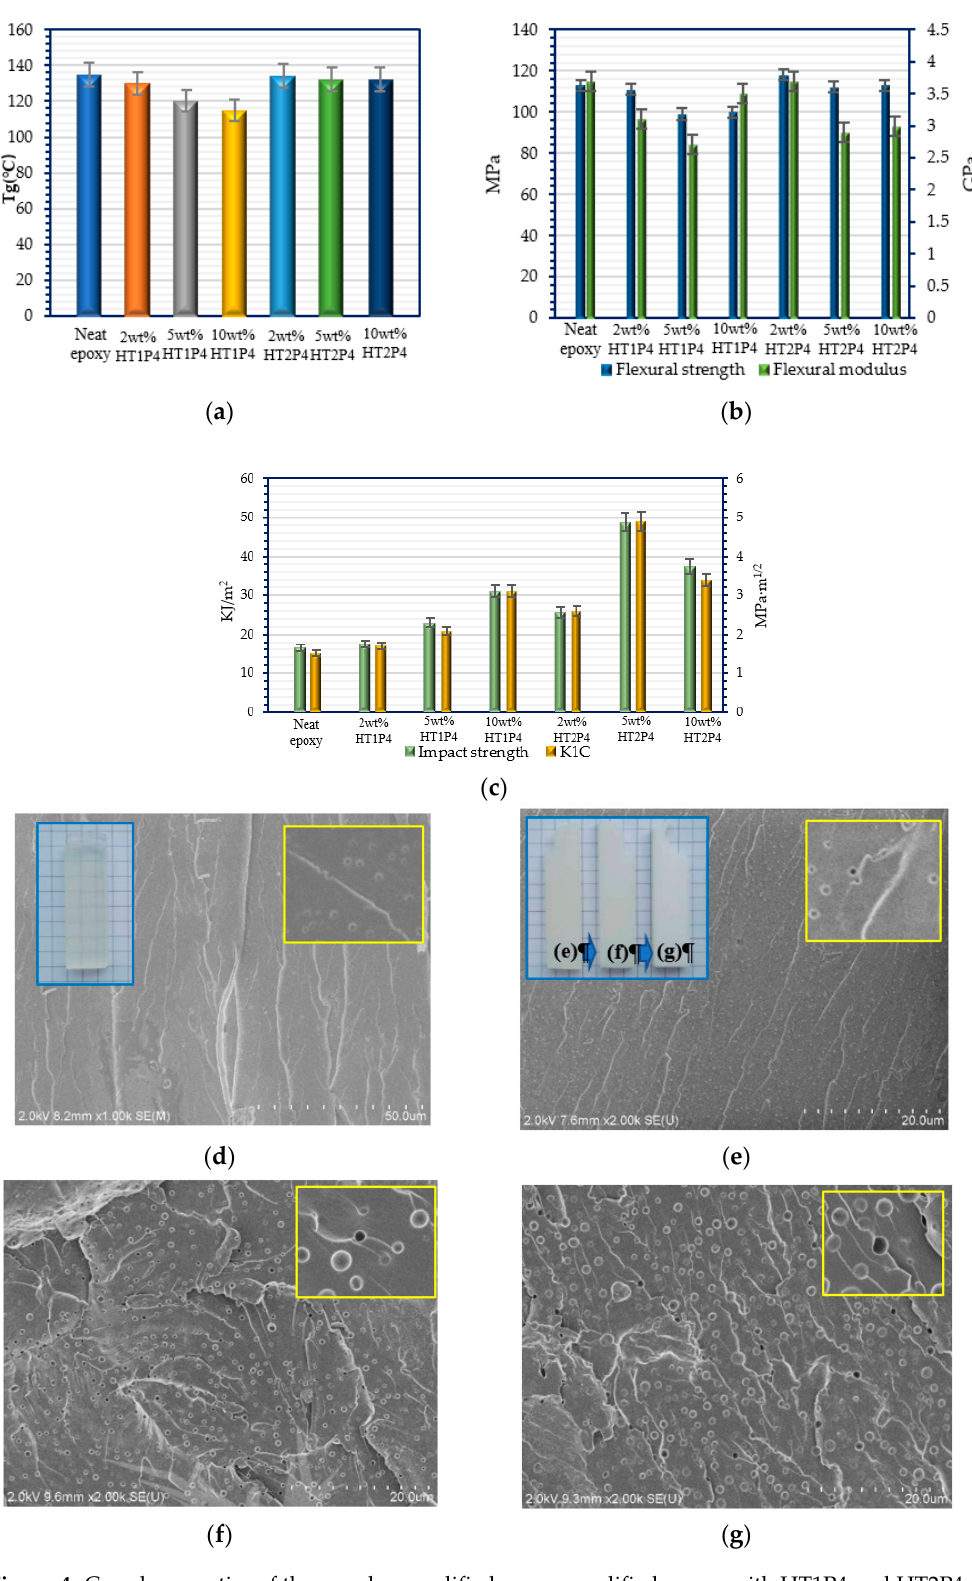
Figure 4. Cured properties of the cured unmodified epoxy, modified epoxy with HT1P4 and HT2P4 at 2, 5 and 10 wt %, respectively ( a ) T g ; ( b ) Flexural strength and modulus; ( c ) Impact strength and K IC ; ( d ) SEM for modified epoxy with 10 wt % HT1P4; ( e ) SEM for modified epoxy with 2 wt % HT2P4; ( f ) SEM for modified epoxy with 5 wt % HT2P4; ( g ) SEM for modified epoxy with 10 wt % HT2P4.